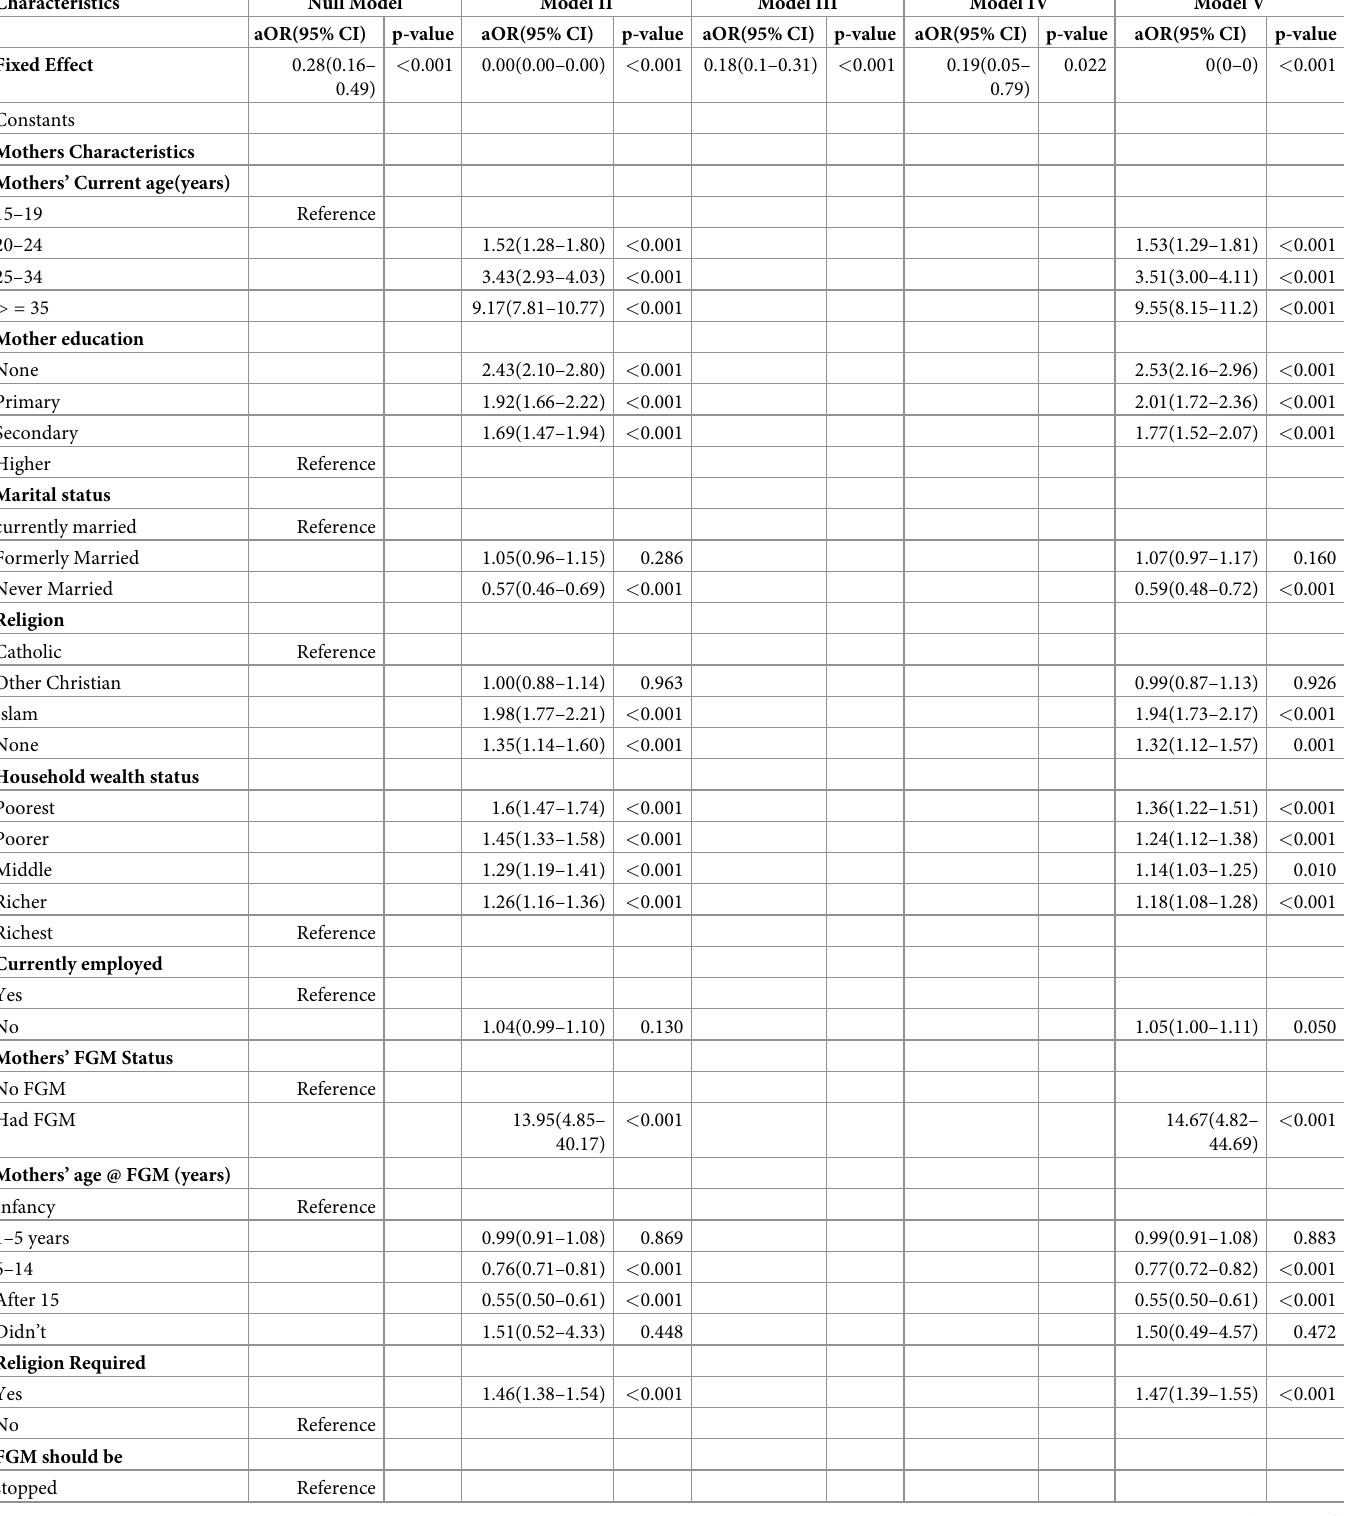
Table 4. Individual, neighbourhood and country level factors associated with daughters’